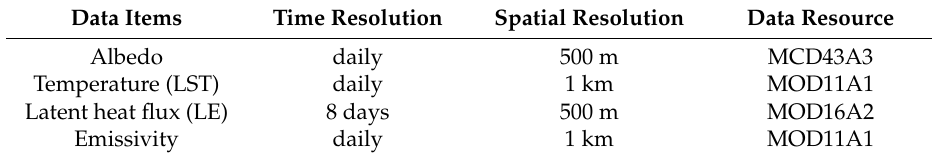
Table 1. Moderate Resolution Imaging Spectroradiometer (MODIS) data items and